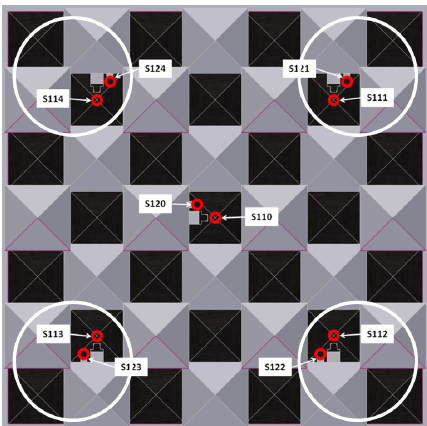
Fig. 3. Left: schematic diagram of a GLORIA blackbody; right: partly assembled prototype version of the pyramid array which forms the radiating optical surface of a GLORIA blackbody. Three different types of uncoated pyramids are noticeable. The position of platinum resistance thermometers in the pyramids and the base plate are marked in blue.